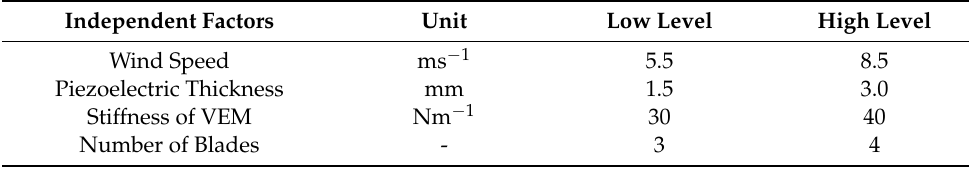
Table 2. Input variables of proposed energy harvester used in